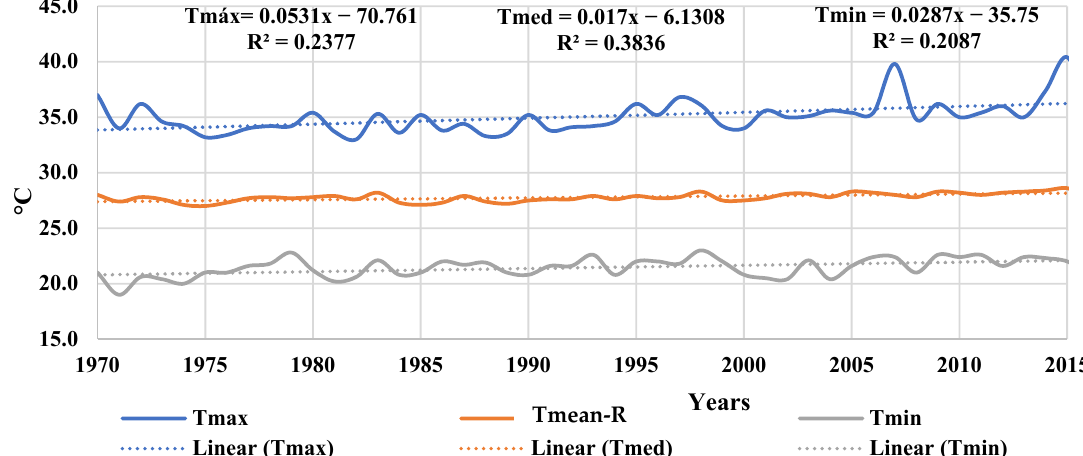
Figure 3. Time series of maximum, mean, and minimum temperatures.